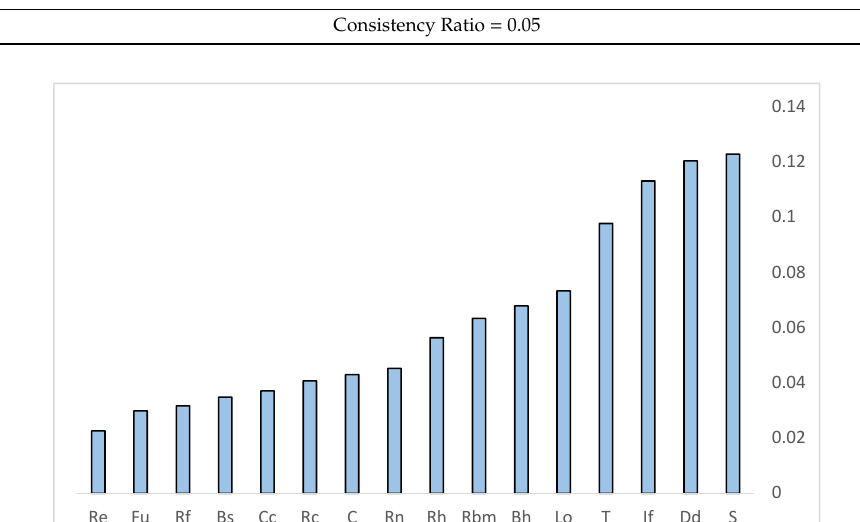
Figure 8. Relative importance of geomorphometric parameters using AHP model.